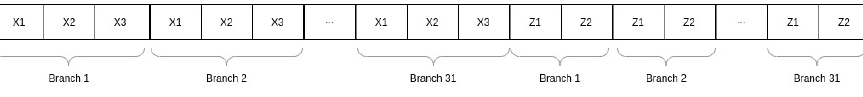
Figure 6. Chromosome representation used in the algorithm.